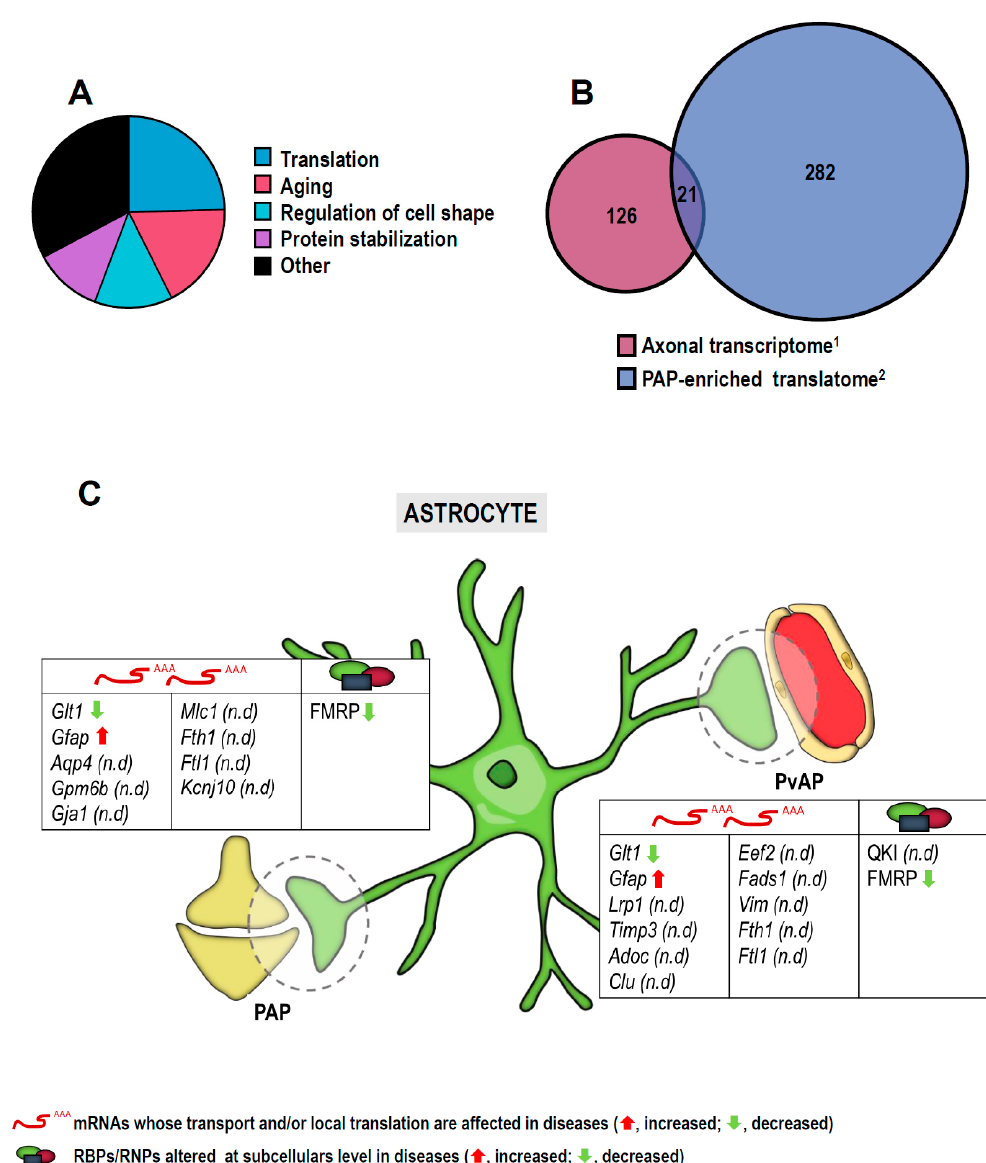
Figure 4. Taking advantage of the detailed analyses performed on the local translatome in astroglial peripheral processes [111,130] and on the axonal transcriptome of A β -treated axons [14], a GO term analysis of common localized transcripts found in astrocytes and neurons is shown (FDR < 0.05) ( A ). Focusing on significantly changed transcripts in A β -treated axons compared to controls ( 1 ), 21 one of them are also found in perisynaptic astrocytic process (PAP) translatome datasets ( 2 ) ( B ). Local translation occurs both in PAPs (upper table) and in perivascular astrocytic processes (PvAPs) (lower table). Arrows indicate altered levels (red, increase; green, decrease) of mRNAs and/or proteins in diseases ( C ). n.d, not described.